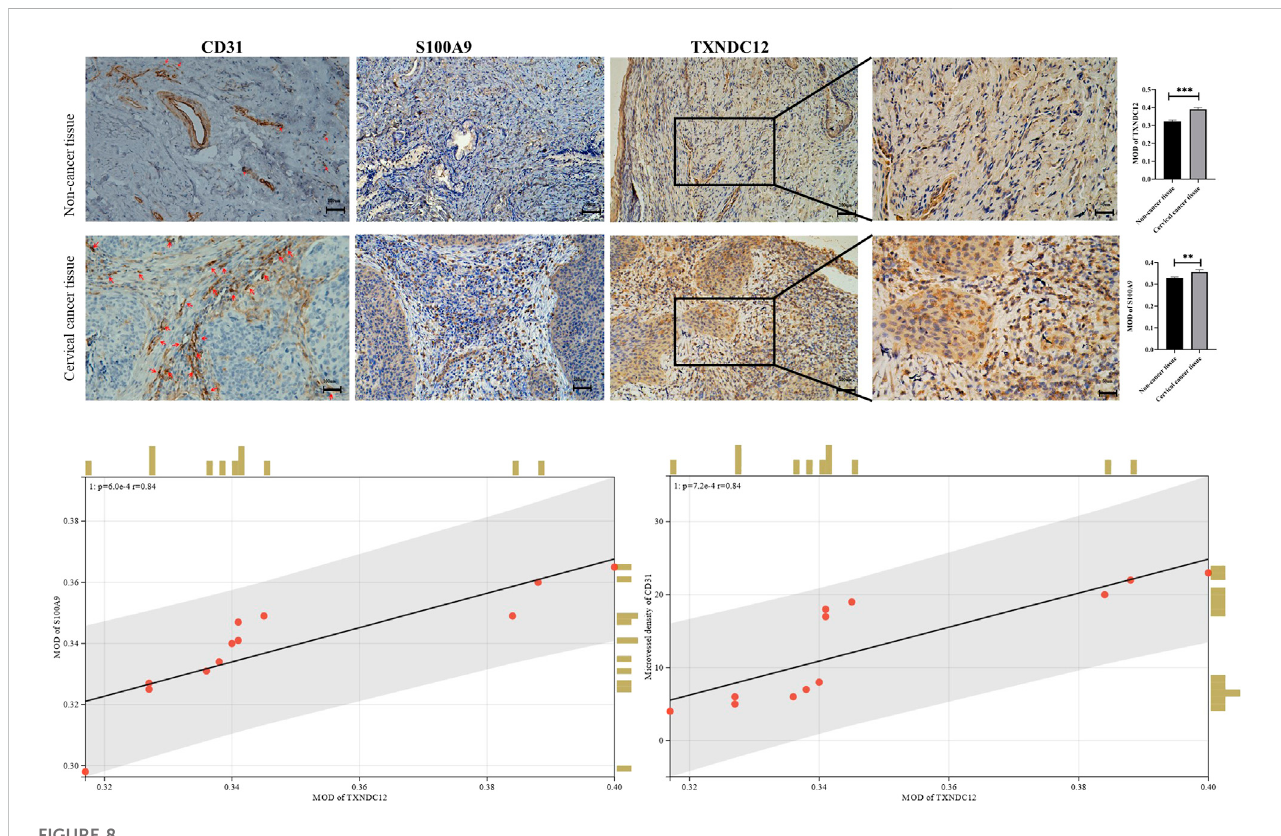
FIGURE 8 Immunohistochemical staining and correlation analysis of CD31, S100A9, TXNDC12.